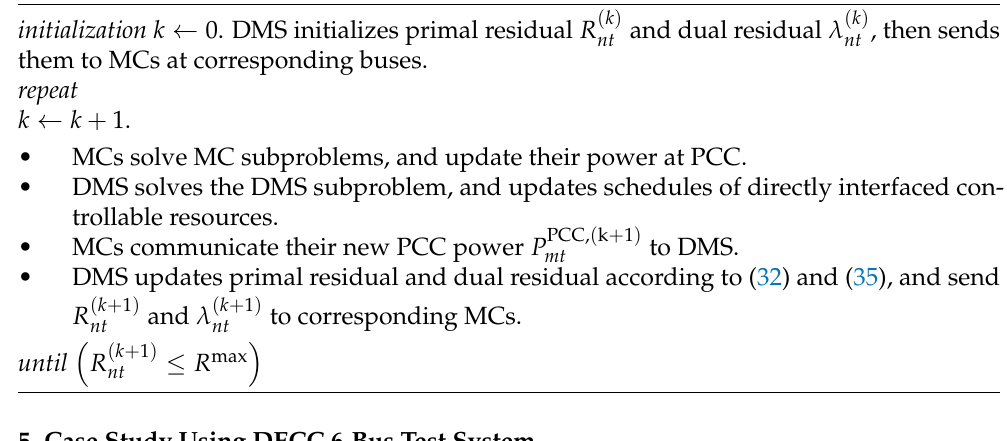
Algorithm 1 Proposed Distributed Energy Management for Networked Microgrids